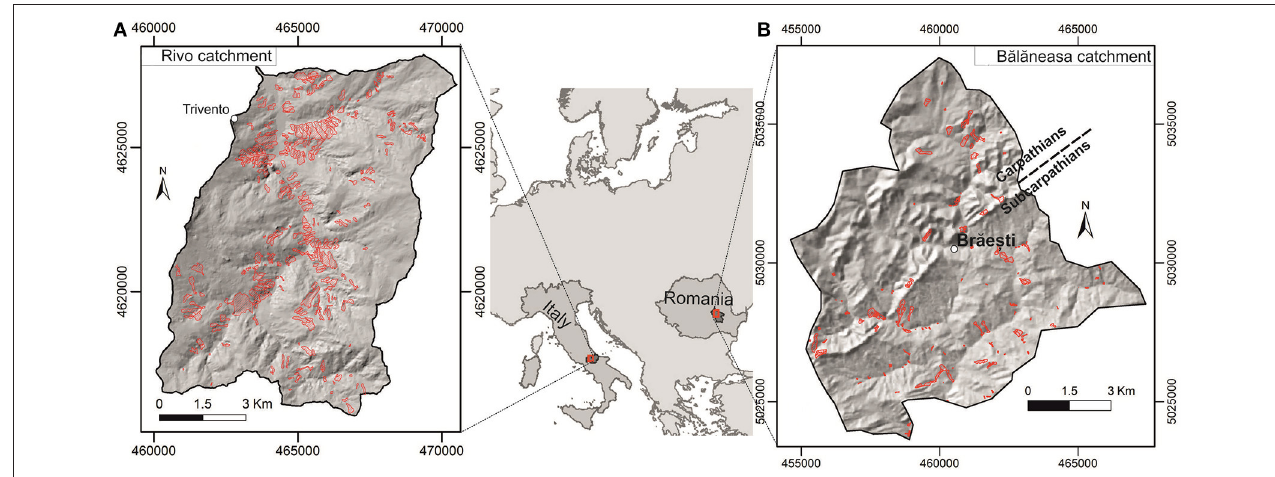
FIGURE 1 | General overview of the study areas locations (in A Rivo catchment; in B Balaneasa catchment) and landslides bodies (reported in red) used for the analysis.